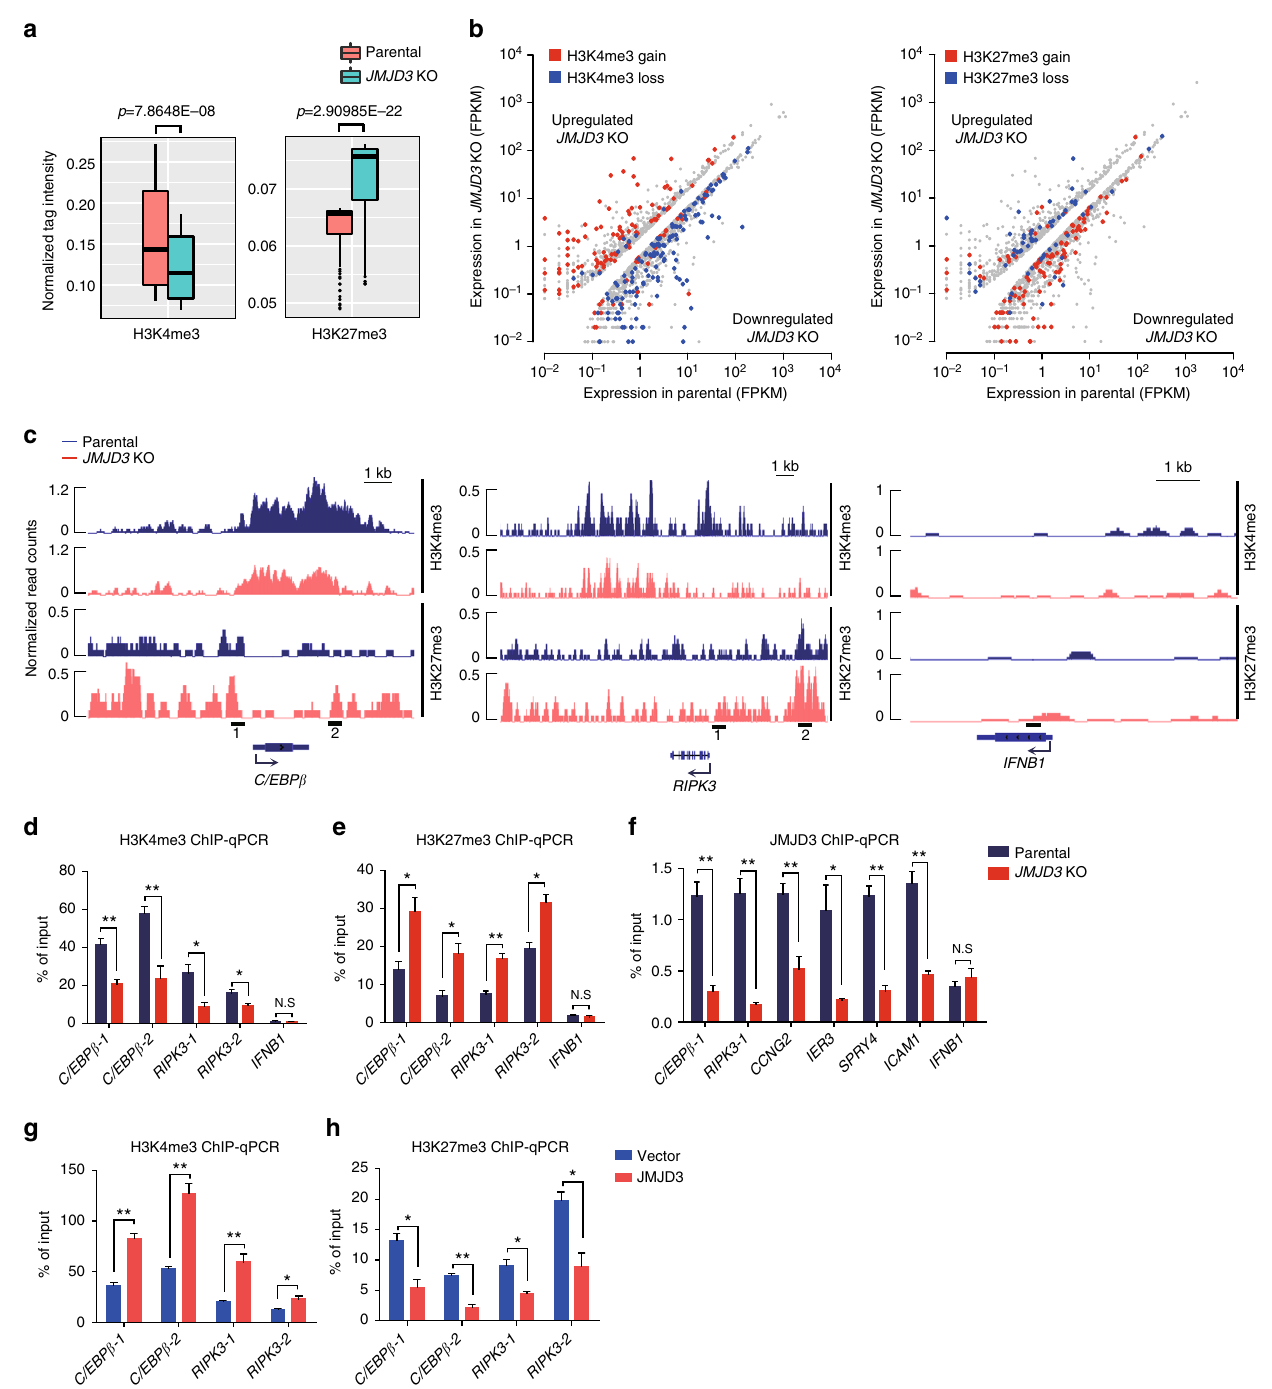
Fig. 5 JMJD3 regulates dynamic H3K4me3 and H3K27me3 modi fi cations in the promoter of myelopoietic genes. a Box plots showing the differences of H3K4me3 (left) and H3K27me3 (right) occupancies around the promoter (with 3 kb upstream or downstream of the TSS) of parental and JMJD3 knockout HL-60 cells. b The loci of the downregulated genes in JMJD3 de fi ciency exhibit a decrease in H3K4me3 (blue dots, left panel) but an increase in H3K27me3 level (red dots, right panel). FPKM, fragments per kilobase of transcript per million fragments mapped. c Genome browser tracks representing the binding sites of H3K4me3 and H3K27me3 at the C/EBP β or RIPK3 gene locus in parental and JMJD3 knockout HL-60 cells. d , e ChIP – qPCR assay for H3K4me3 ( d ) and H3K27me3 ( e ) at the C/EBP β , RIPK3 or IFNB gene locus in parental and JMJD3 knockout HL-60 cells. f ChIP – qPCR assay for JMJD3 occupancy at a number of gene loci in parental and JMJD3 knockout HL-60 cells. g , h ChIP – qPCR assay for H3K4me3 ( g ) and H3K27me3 ( h ) at the C/EBP β or RIPK3 gene locus in HL-60 cells transduced with empty vector or JMJD3-expressing vector. Data are shown as the mean ± SEM; * p < 0.05, ** p <